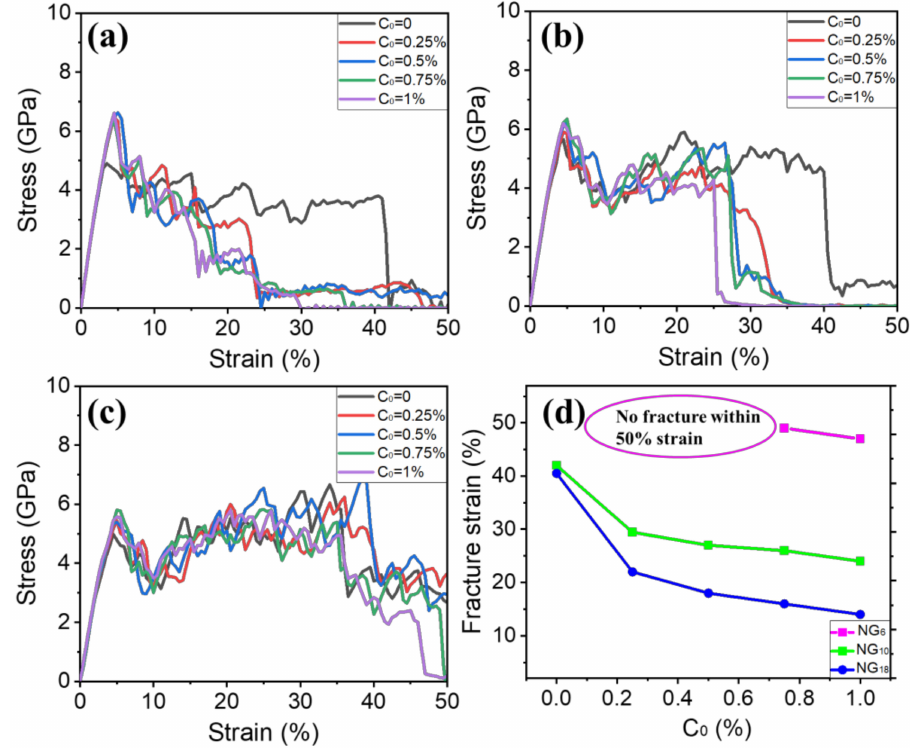
Figure 5. ( a – c ) Tensile stress–strain curves of NG 18 , NG 10 and NG 6 models, respectively, with different bulk H concentrations; ( d ) fracture strain as a function of C 0